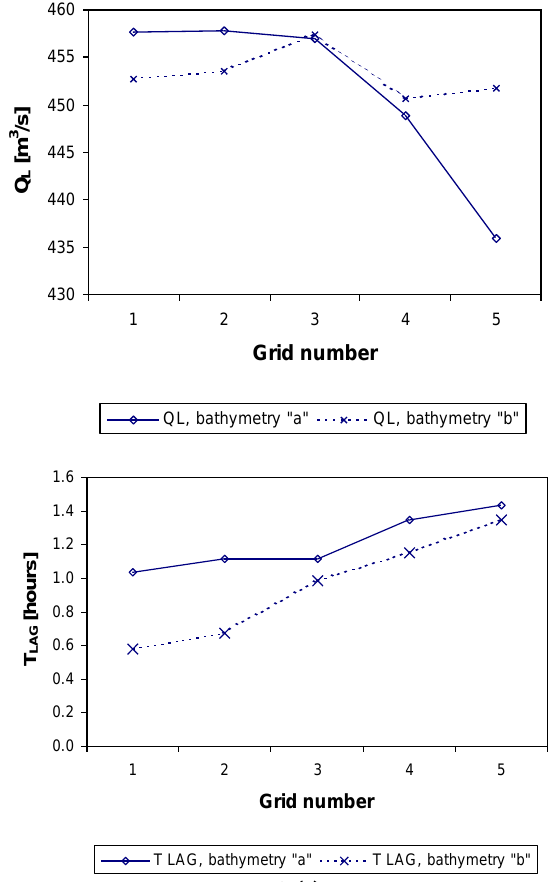
Figure 4. Comparison of: (a) liquid peak discharges downstream of reach; (b) lag time for hydrodynamic simulation with different resolution data (grid and model